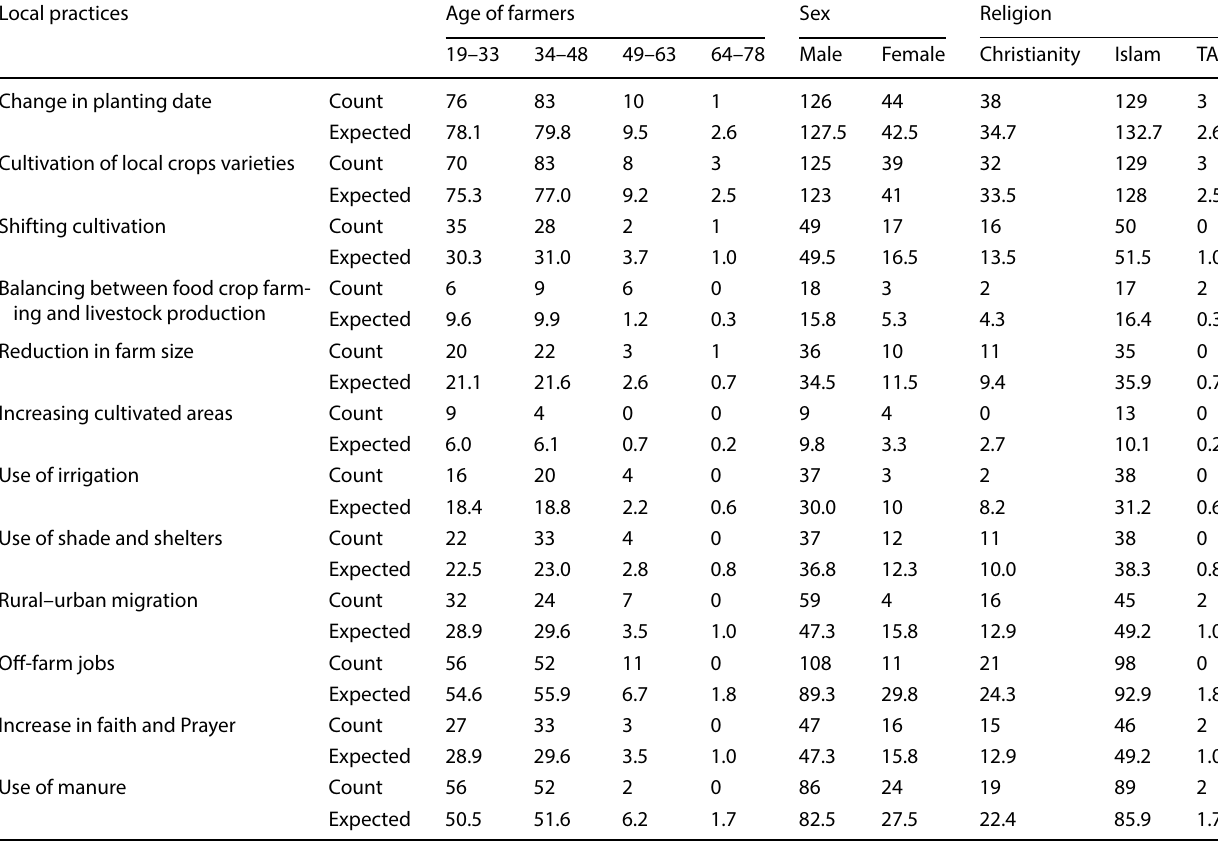
Table 3 Local practices for adapting food crops production to climate